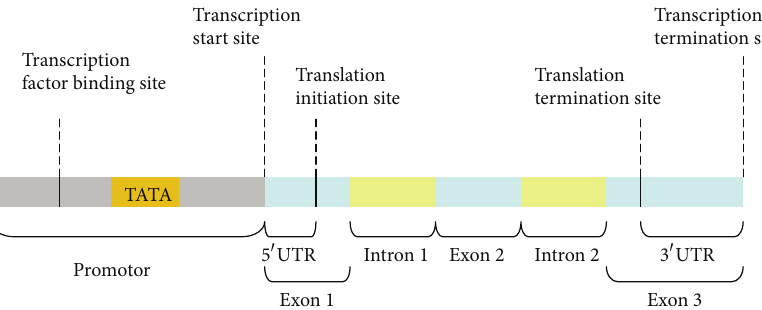
Figure 1: The promoter of a DNA sequence containing a transcription factor binding site and a TATA box is immediately upstream to a transcription start